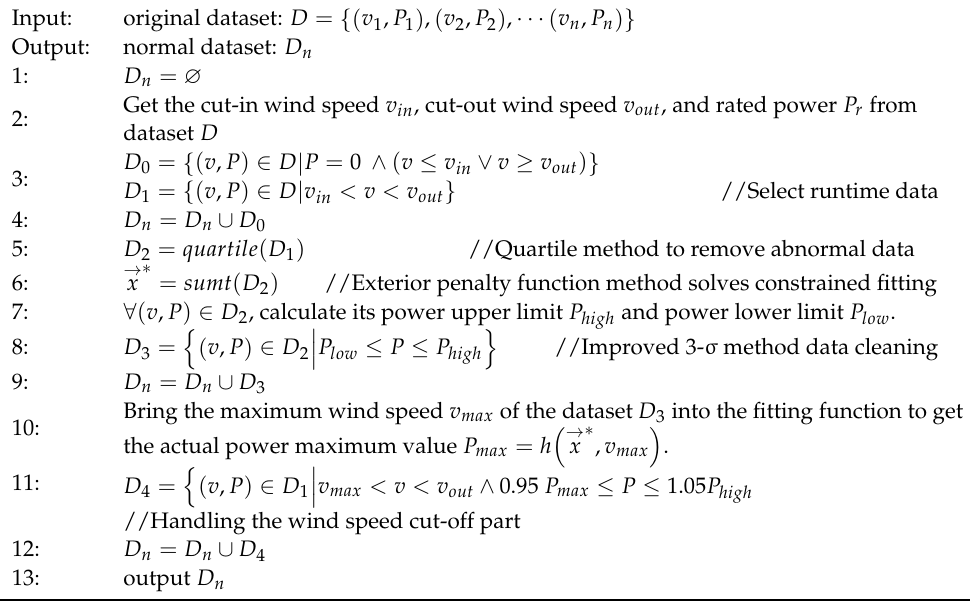
Algorithm 2 Abnormal Data Cleaning Method for Wind Turbines Based on Constrained Curve